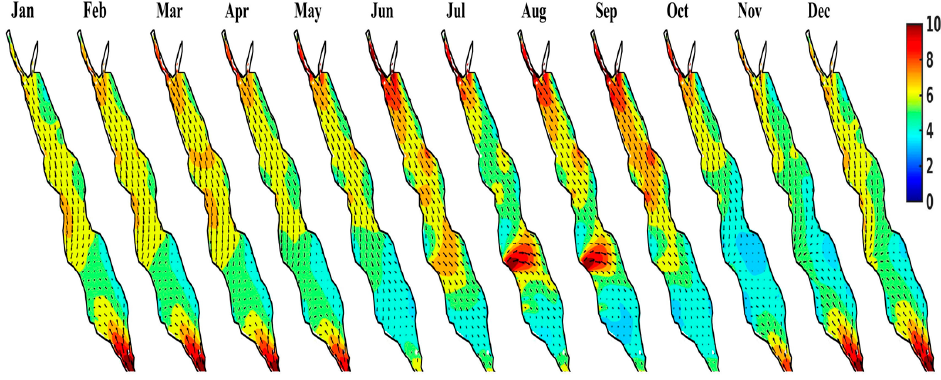
Figure 8. Average monthly wind speed (m s ⁻ 1 ) over the Red Sea in the GCC region at a height of 50–120 m, based on historical data spanning 18 years. Copyright © 2021 Elsevier